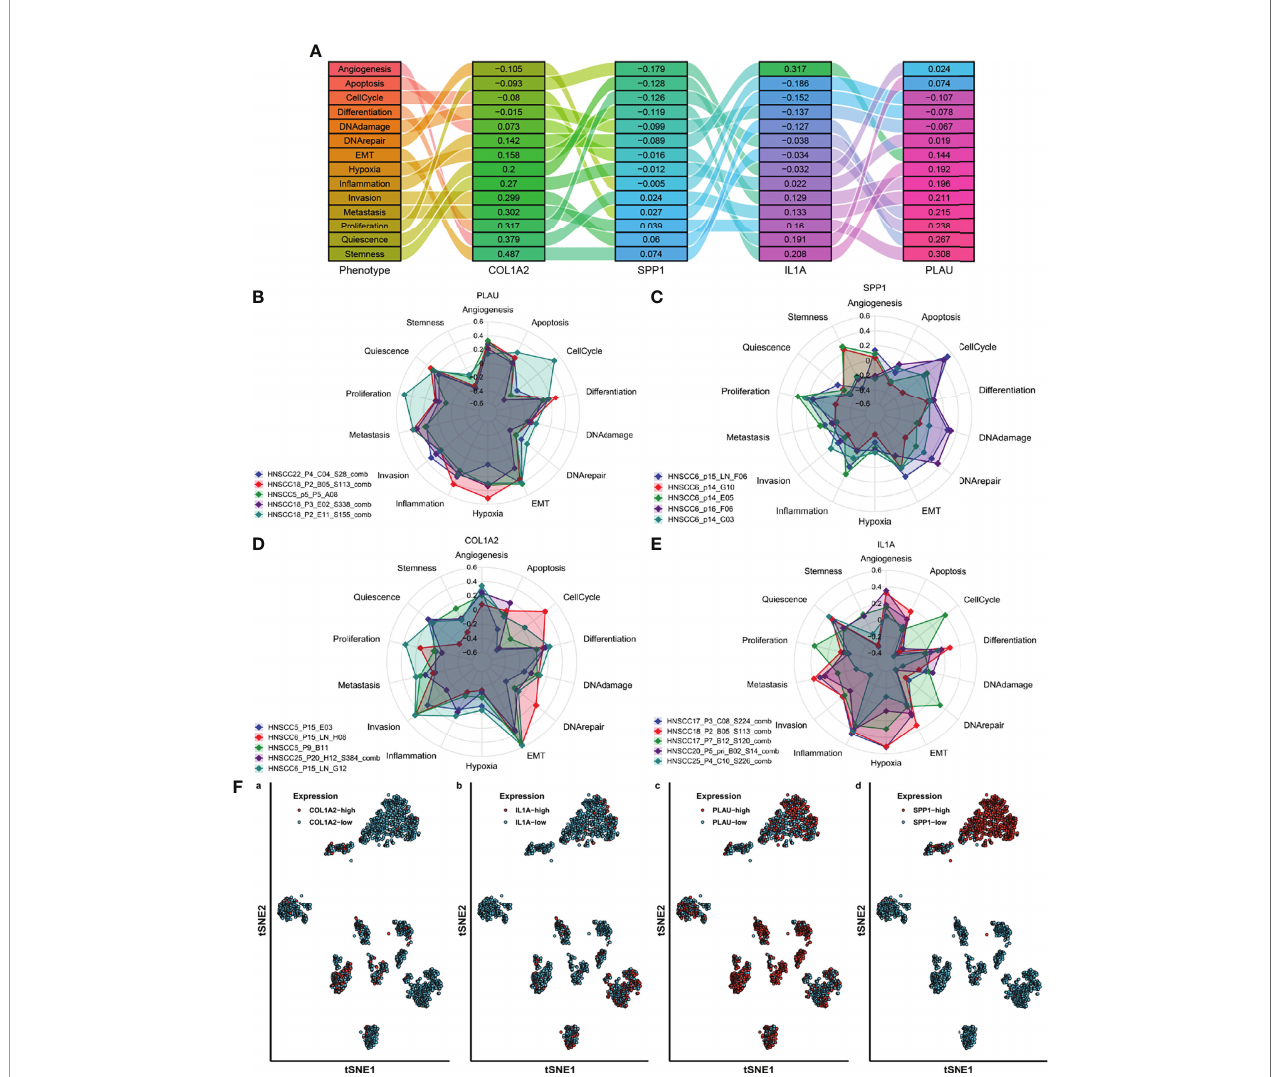
FIGURE 10 | Single-cell classi fi cation functional enrichment results of AFOC-DEGs. (A) Phenotypic Sankey diagram of cell function enrichment. (B) Radar map of phenotype distribution of OSCC cells with high PLAU expression. (C) Radar map of phenotype distribution of OSCC cells with high SPP1 expression. (D) Radar map of phenotype distribution of OSCC cells with high COL1A2 expression. (E) Radar map of phenotype distribution of OSCC cells with high IL1A expression. (F) TSNE cell sorting results from single-cell sequencing. OSCC, oral squamous cell